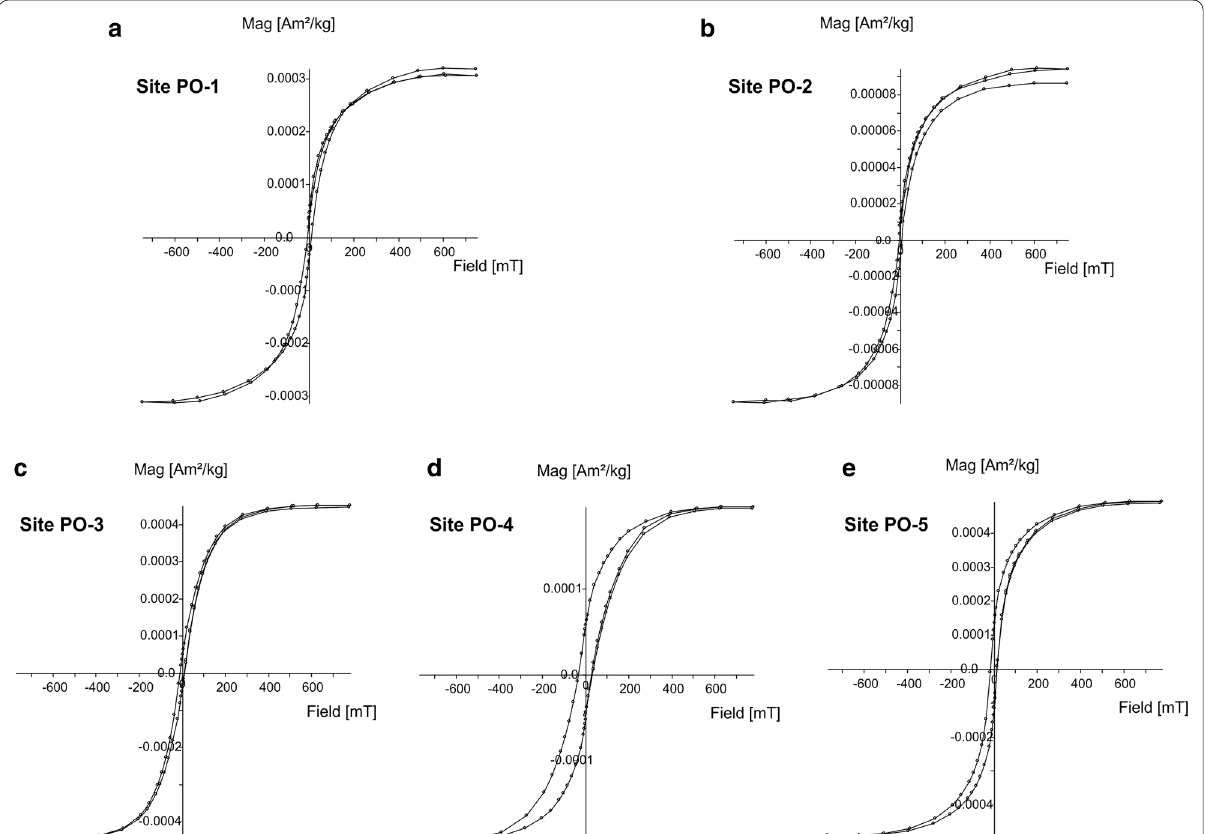
Fig. 8 Representative examples of hysteresis plots for the two scorias of the two PDCs sampled (upper plots) and lava flows (lower plots)